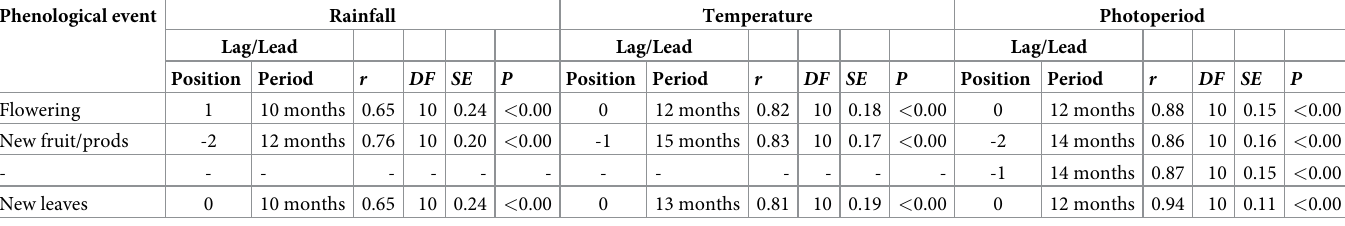
Table 3. Lag and lead results for flowering, new fruit/pods and new leaves with rainfall, temperature and photoperiod. If a lag or lead was present, it is indicated in the ‘position’ column. Noticeable lags and leads were found for flowering and rainfall, and for new fruit/pods with rainfall, temperature and photoperiod. No lags were found for new leaves.